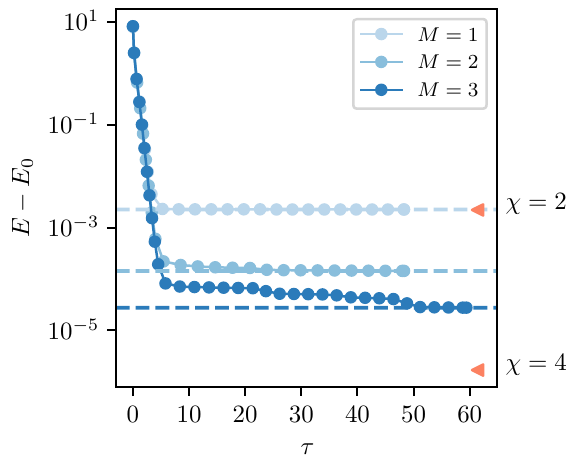
FIG. 5. We perform imaginary-time evolution for circuits of order M = 1, 2, 3 for the quantum Ising model with N = 31, g = 1.2, h = 0.1. To find the optimal performance of our